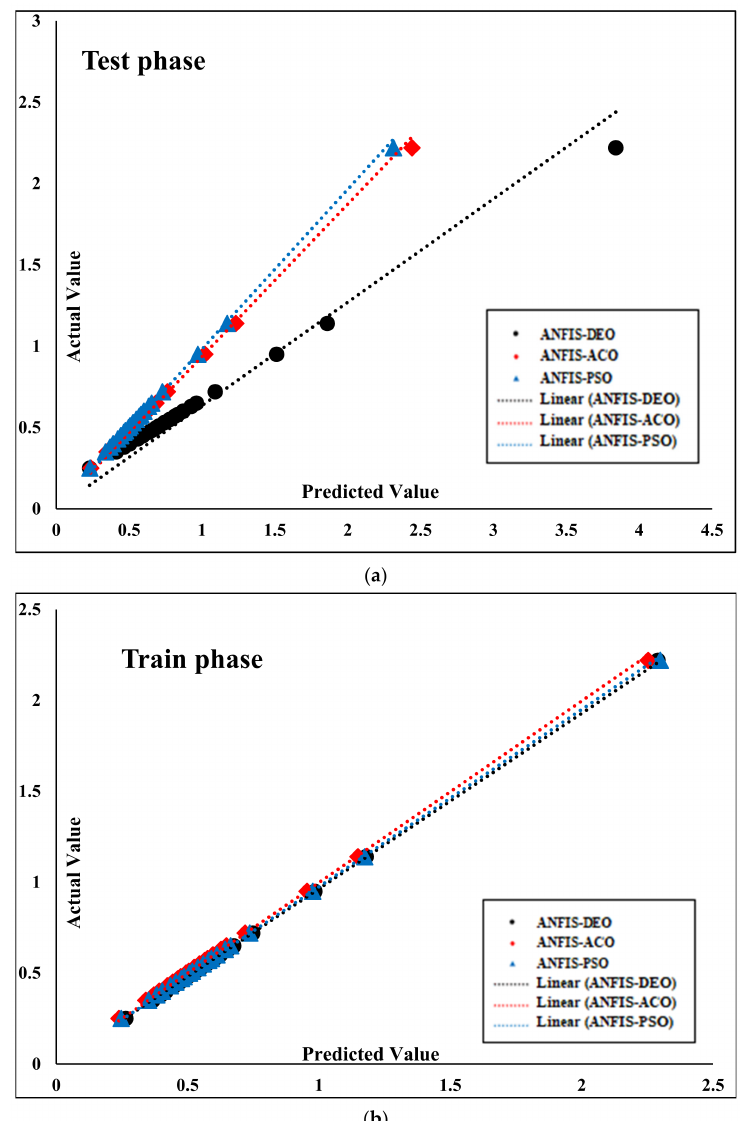
Figure 11. Comparison of regression lines: ( a ) Testing phase, ( b ) training phase.